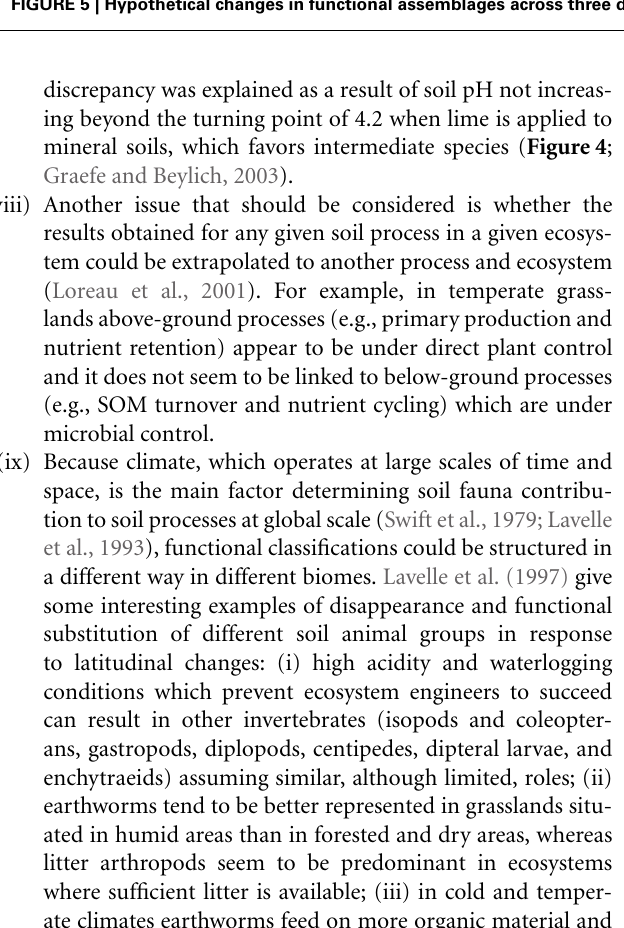
FIGURE 5 | Hypothetical changes in functional assemblages across three different